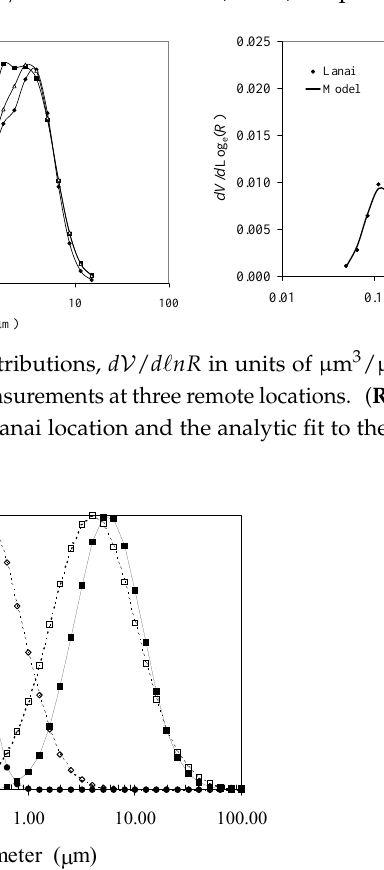
Figure 10. Comparison between the Shettle and Fenn [ dV / d (cid:96) nD ] and the Smirnov et al. [ d V / d (cid:96) nD ] (Lanai) size distributions for the fine and coarse modes. Each mode has been normalized to unity at the size of maximum dV / d (cid:96) nD . Note that in contrast to Figure 9, the horizontal axis is particle diameter as opposed to radius. The values of V T for the fine and coarse modes at Lanai are 0.010 and 0.039 µ m 3 / µ m 2 , respectively. (Taken from